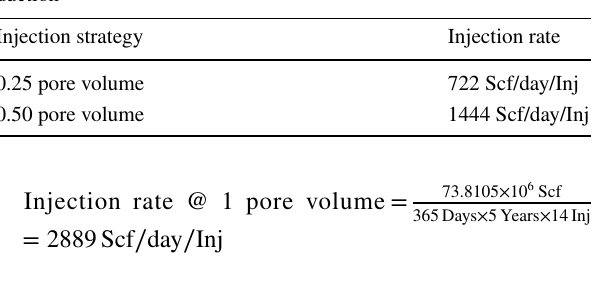
Table 4 Various injection strategies implemented to optimize oil pro-